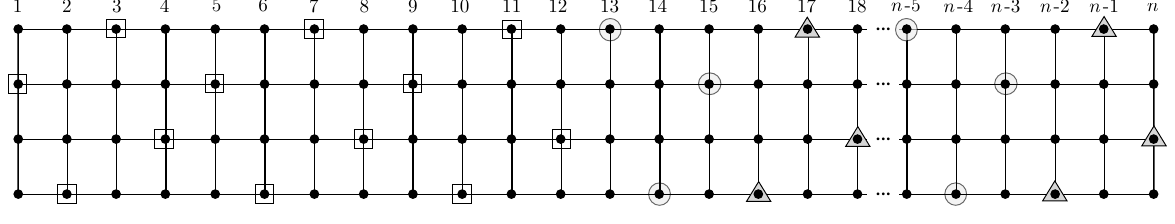
Figure 16: The dominating set D